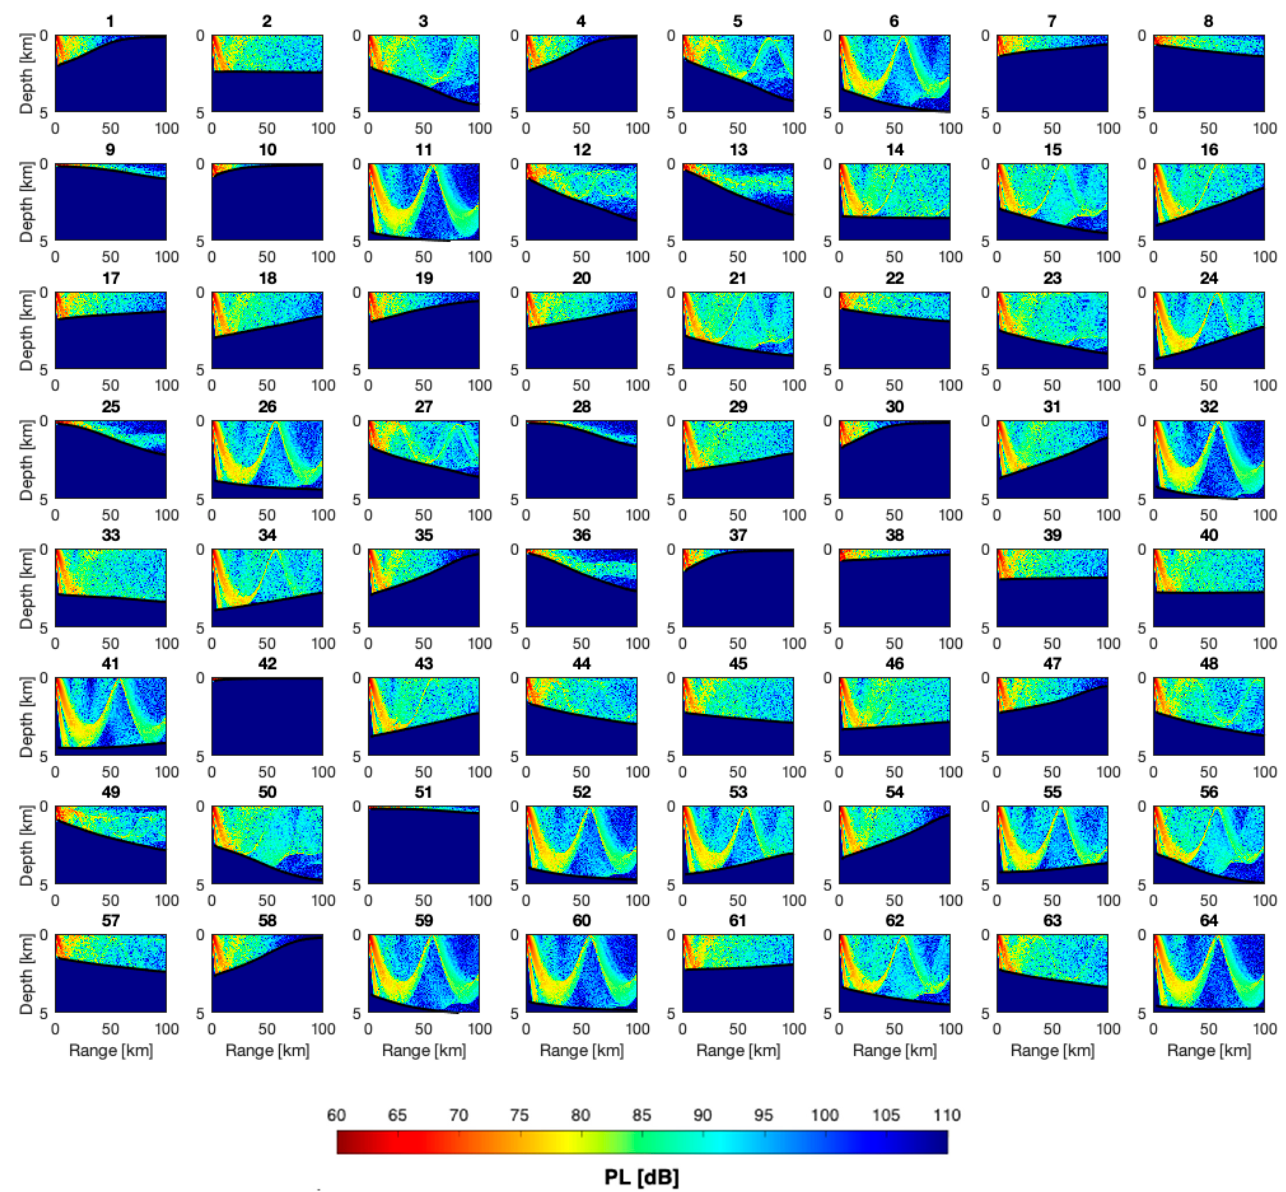
Figure 5. Plots of propagation loss (PL) as a function of range and depth along the 64 centroid bathymetries from Zone 16, for a frequency of 640 Hz. The darkest red corresponds to 60 dB and the darkest blue to 110 dB. X-axes are range (km) and Y-axes are depth below the sea surface (km); both are scaled linearly.